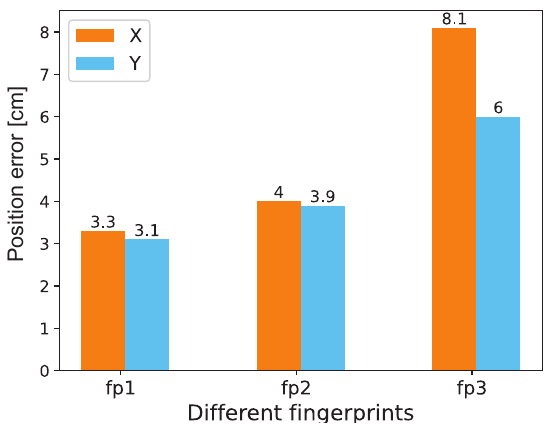
Figure 8. Impact of fingerprints collected in different